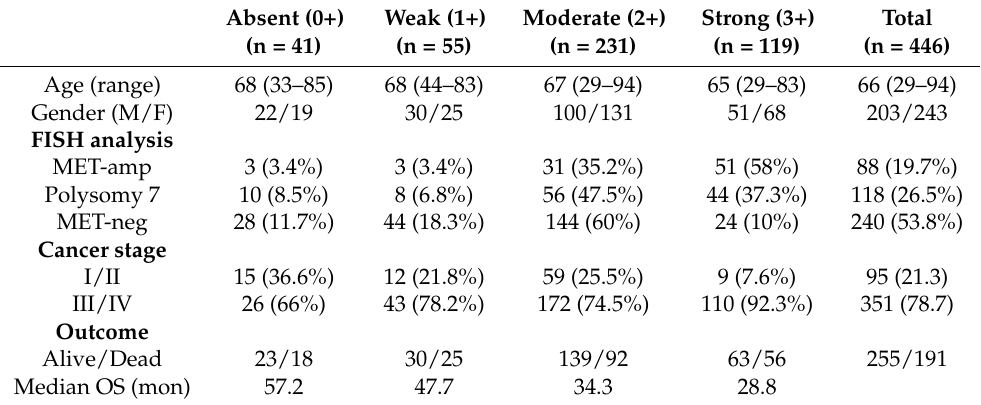
Table 1. Associations of MET expression level with MET copy number, cancer stage and